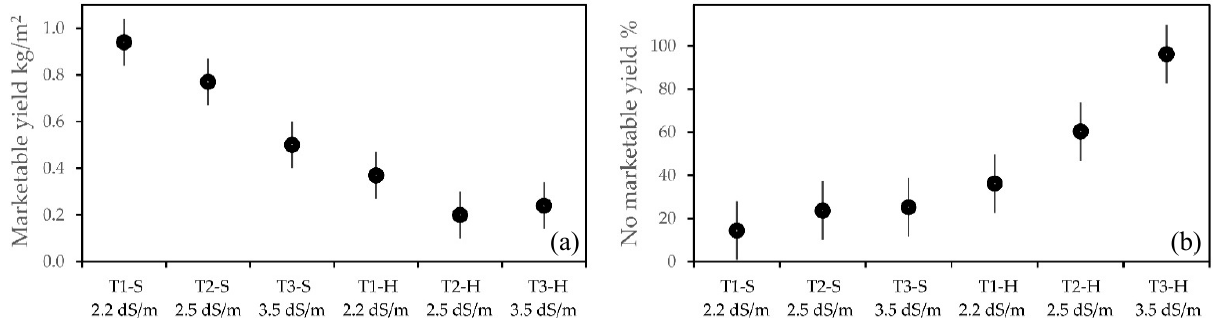
Figure 9. Comparison of the marketable ( a ) and non-marketable ( b ) yield in different treatments and crop systems in harvest at 9 March 2021. T1-S, 0.6 dS m − 1 EC irrigation water + 1.6 dS m − 1 EC fertilization in typical soil substrate “ enarenado ”; T2-S, 1.5 dS m − 1 EC irrigation water + 1 dS m − 1 EC fertilization in typical soil substrate “ enarenado ”; T3-S, 3 dS m − 1 EC irrigation water + 0.5 dS m − 1 EC fertilization in typical soil substrate “ enarenado ”; T1-H, 0.6 dS m − 1 EC irrigation water + 1.6 dS m − 1 EC fertilization in coconut fiber substrate; T2-H, 1.5 dS m − 1 EC irrigation water + 1 dS m − 1 EC